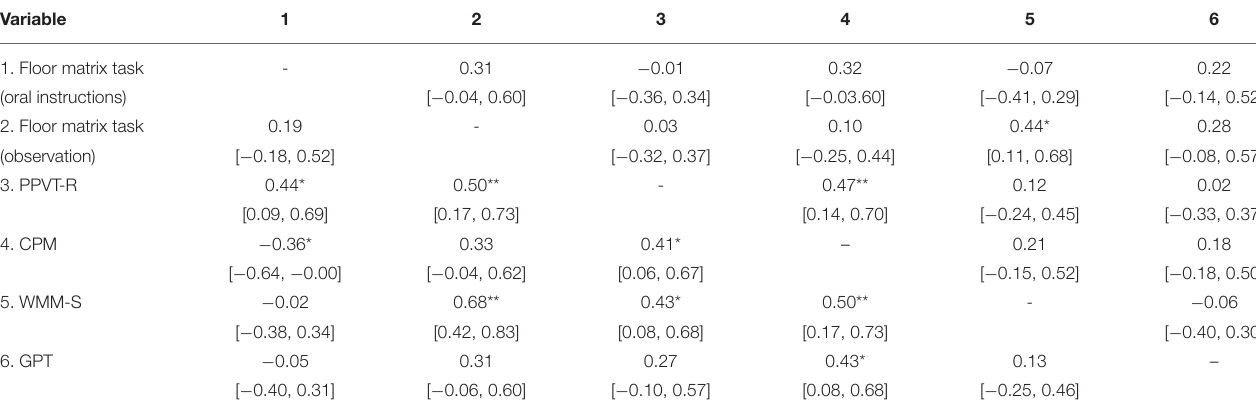
TABLE 2 | Correlations with confidence intervals for individuals with DS (below diagonal, N = 30), and typically-developing (TD) children (above diagonal, N = 32).